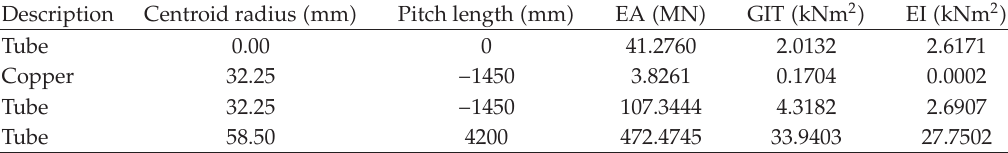
Table 5: Umbilical 2 parameters.